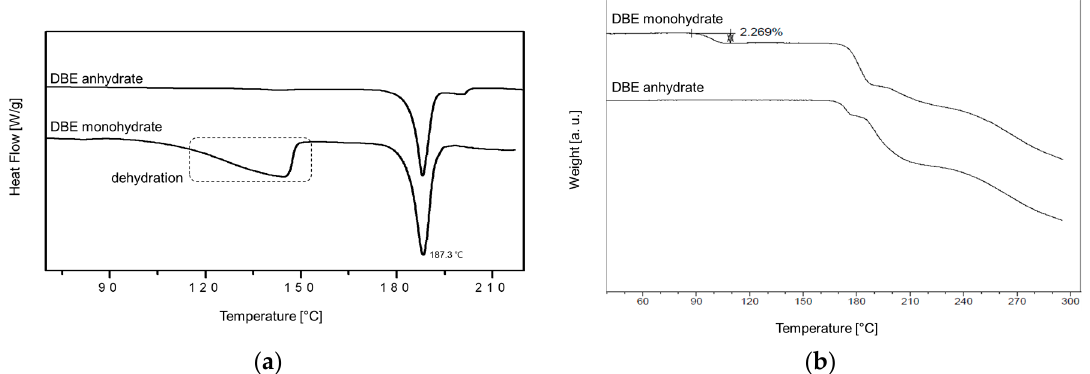
Figure 5. Results of thermal analysis of DBE crystal forms (10 °C/min): ( a ) Differential Scanning Calorimetry (DSC), ( b ) Thermogravimetric Analysis (TGA).